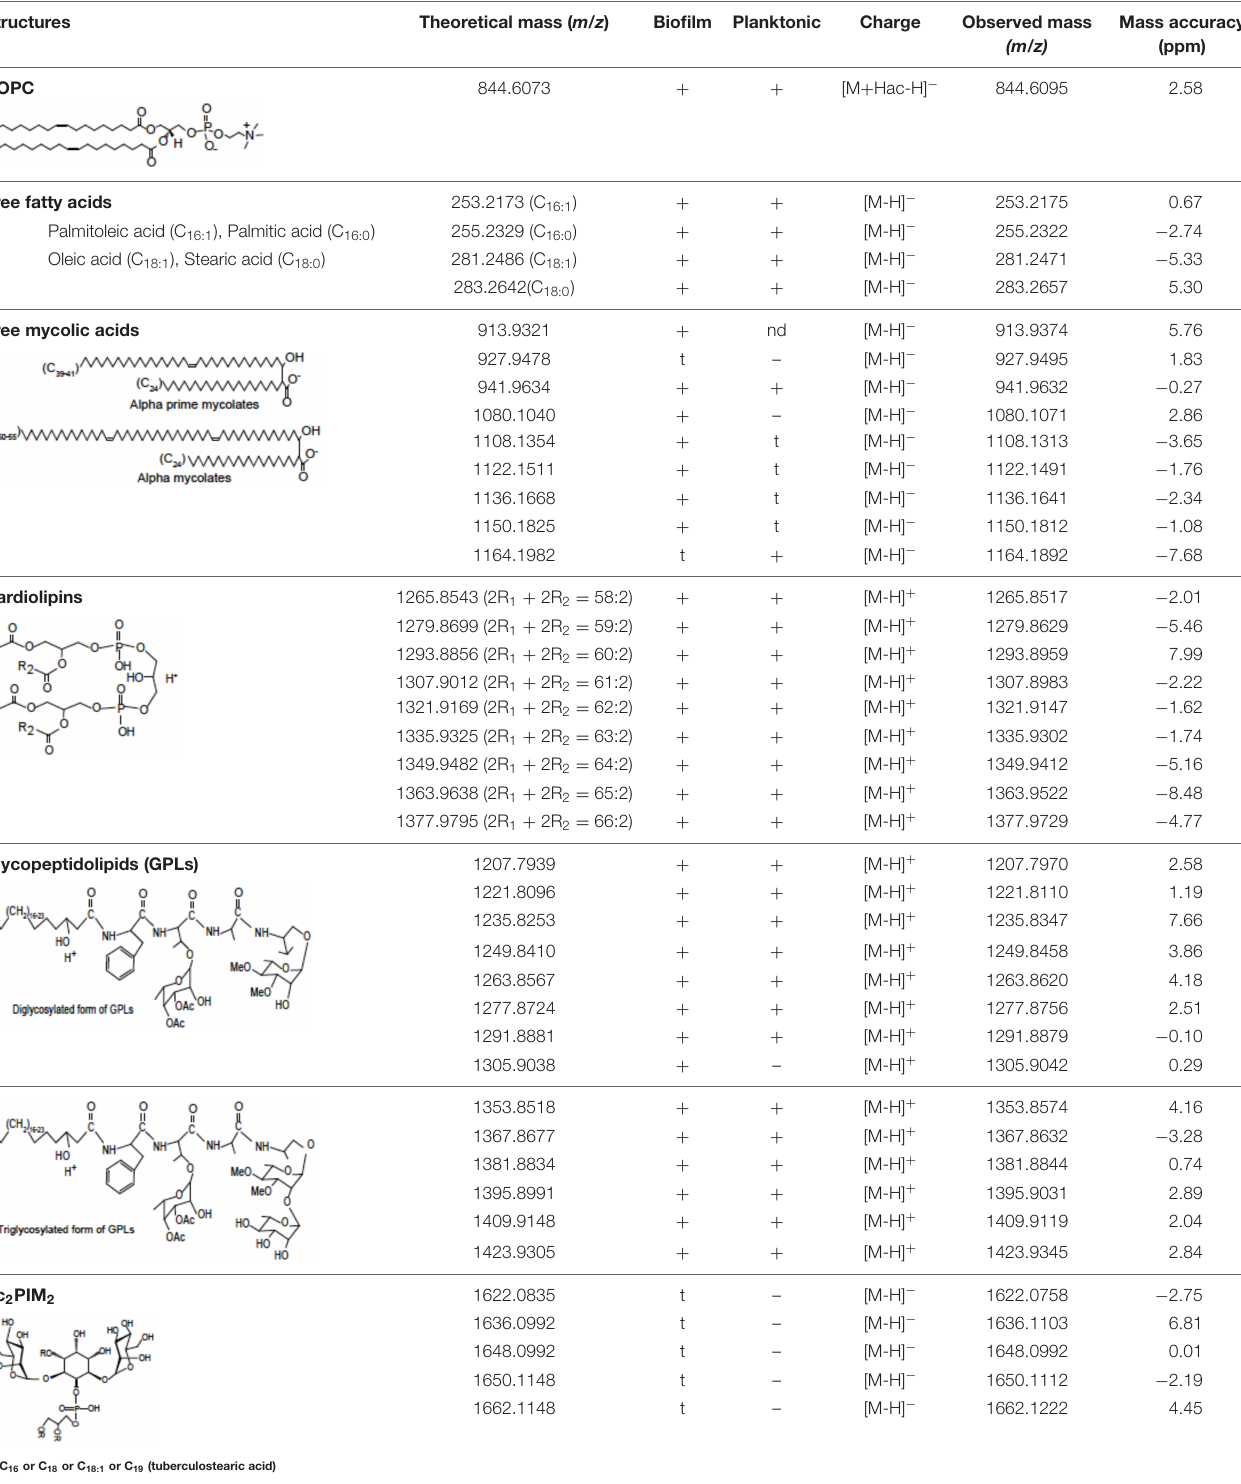
TABLE 3 | Lipid composition of the ECM of planktonically- and biofilm-grown Mabs NJH12.